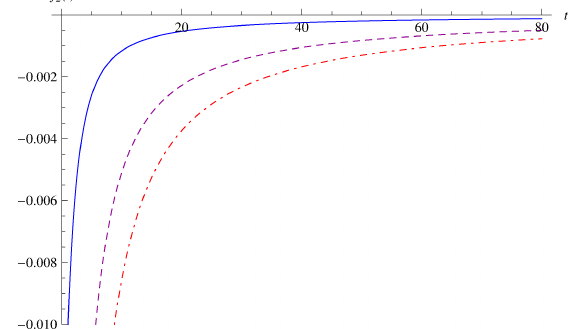
Fig. 6. The curves of f 2 .t/ for b D c D 1 and for ˛ D 1:01 (solid line), ˛ D 1:05 (dash line) and ˛ D 1:1 (dot-dash